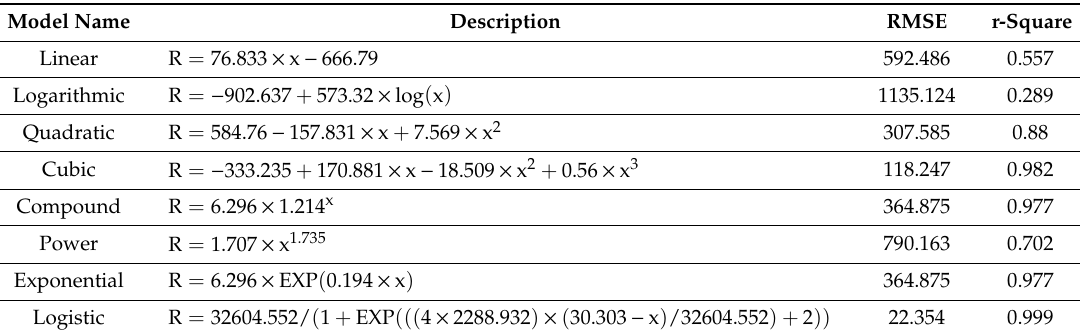
Table 15. Model description for USA fitted by GWO.